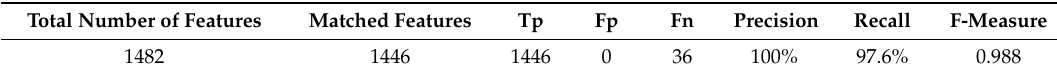
Table 4. Results obtained by matching LC full scan HRMS data of a wheat sample (serving as a target file) to a list of MetExtract-derived features from the same datafile (serving as the reference list)